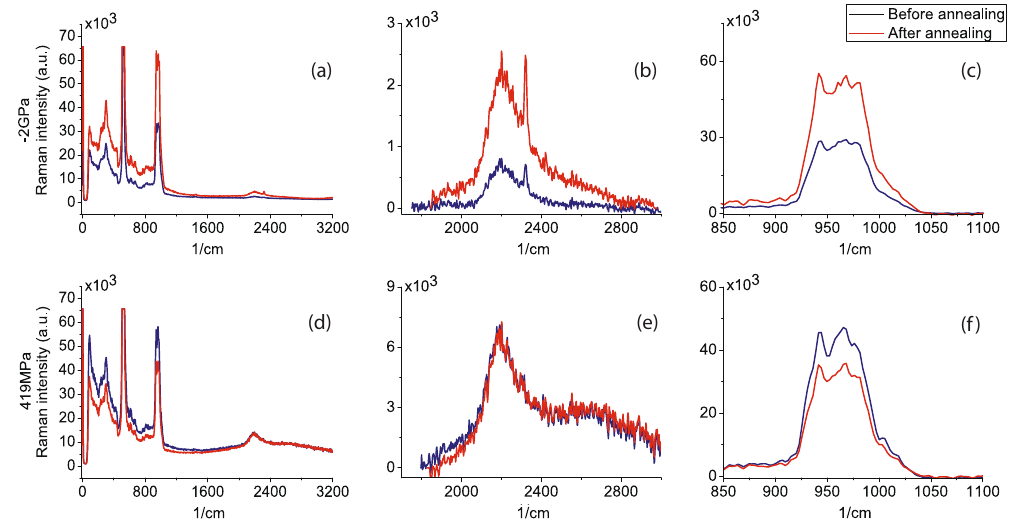
Figure 6. Raman spectra. Top Figures show Raman spectra obtained for the compressive stress sample, where ( a ) shows the complete Raman spectra and Figures ( b and c ) show a zoom on the range where peaks related to Si-H and Si-N bonds are located respectively. Analogously, ( d ) shows the complete Raman spectra for the 419 MPa sample and Figures ( e and f ) show a zoom on Si-H, Si-N related peaks.